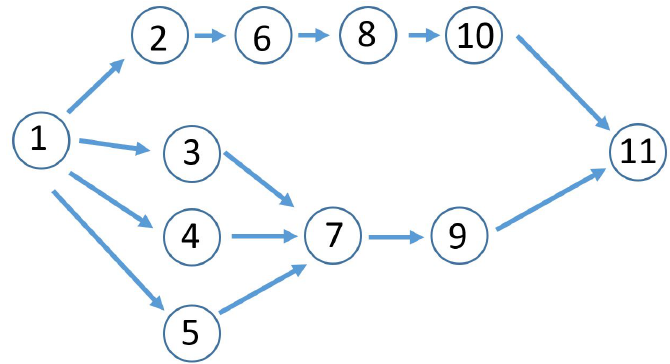
Figure 4. Precedence graph of the example problem taken from Jackson